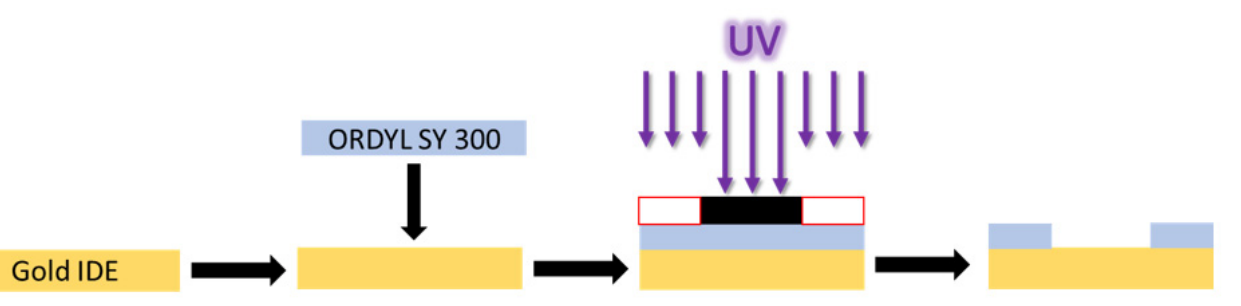
Figure 1. Coating and patterning ORDYL SY 300 at gold IDE surface.